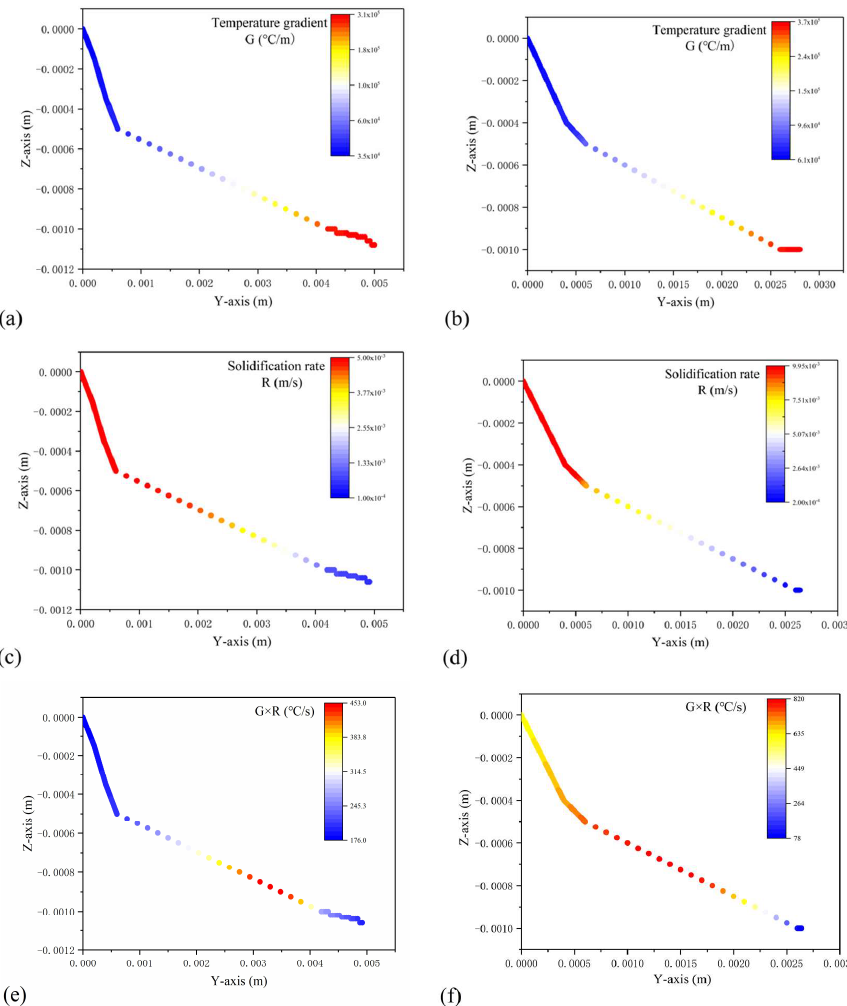
Figure 16. The distribution of G , R , and G / R : ( a ) G (0.005 m/s); ( b ) G (0.01 m/s); ( c ) R (0.005 m/s); ( d ) R (0.01 m/s); ( e ) G / R (0.005 m/s); and ( f ) G / R (0.01 m/s).